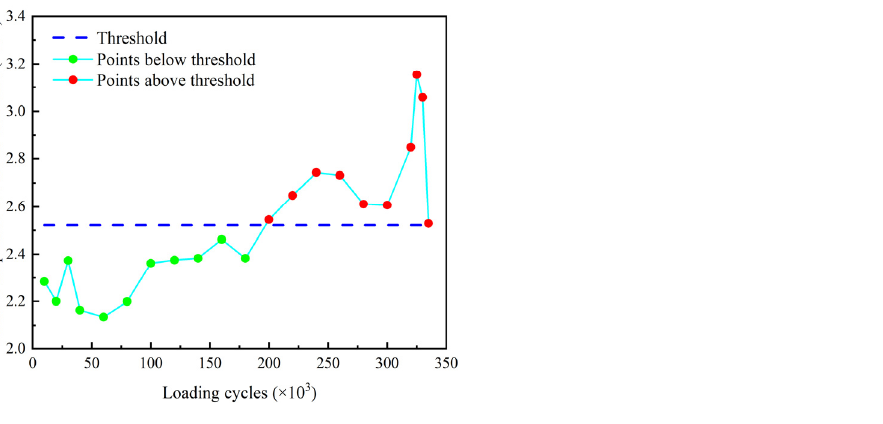
Figure 32. Relative amplitude of second harmonic β (cid:48) re versus loading cycles corresponding to 10-cycle excitation signal.